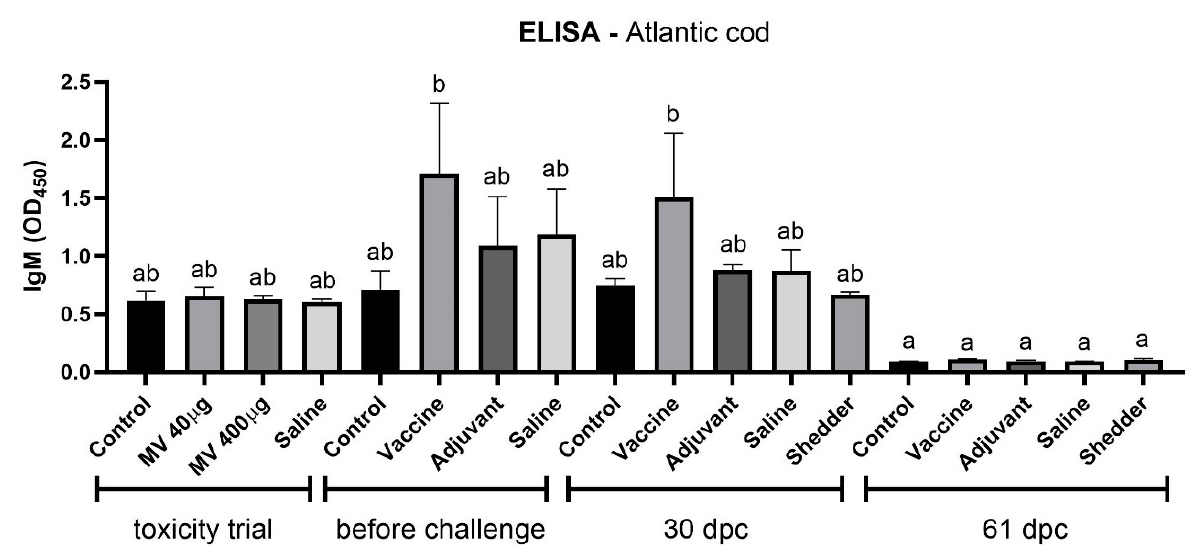
Figure 4. Detection of anti- Fnn IgM in the serum of Atlantic cod immunized with Fnn MVs assayed by ELISA in both the toxicity and vaccine trials. In the toxicity trial, the fish were immunized with either 40 or 400 µ g of Fnn MVs. In the vaccine trial, the fish were immunized with either 40 µ g of Fnn MVs mixed with an adjuvant or with adjuvant alone. In both trials, a saline-injected group was included in addition to an untreated group (control). In the toxicity trial, the serum was collected 14 days after Fnn MV injection. Serum samples were obtained from three fish from each respective group at given time-points during the vaccine experiment. Results marked with different letters (a; b) show the significant difference; groups that do not share letters are significantly different ( p < 0.05; one-way ANOVA with multiple comparison using Tukey test; error bars indicate mean ± SEM).